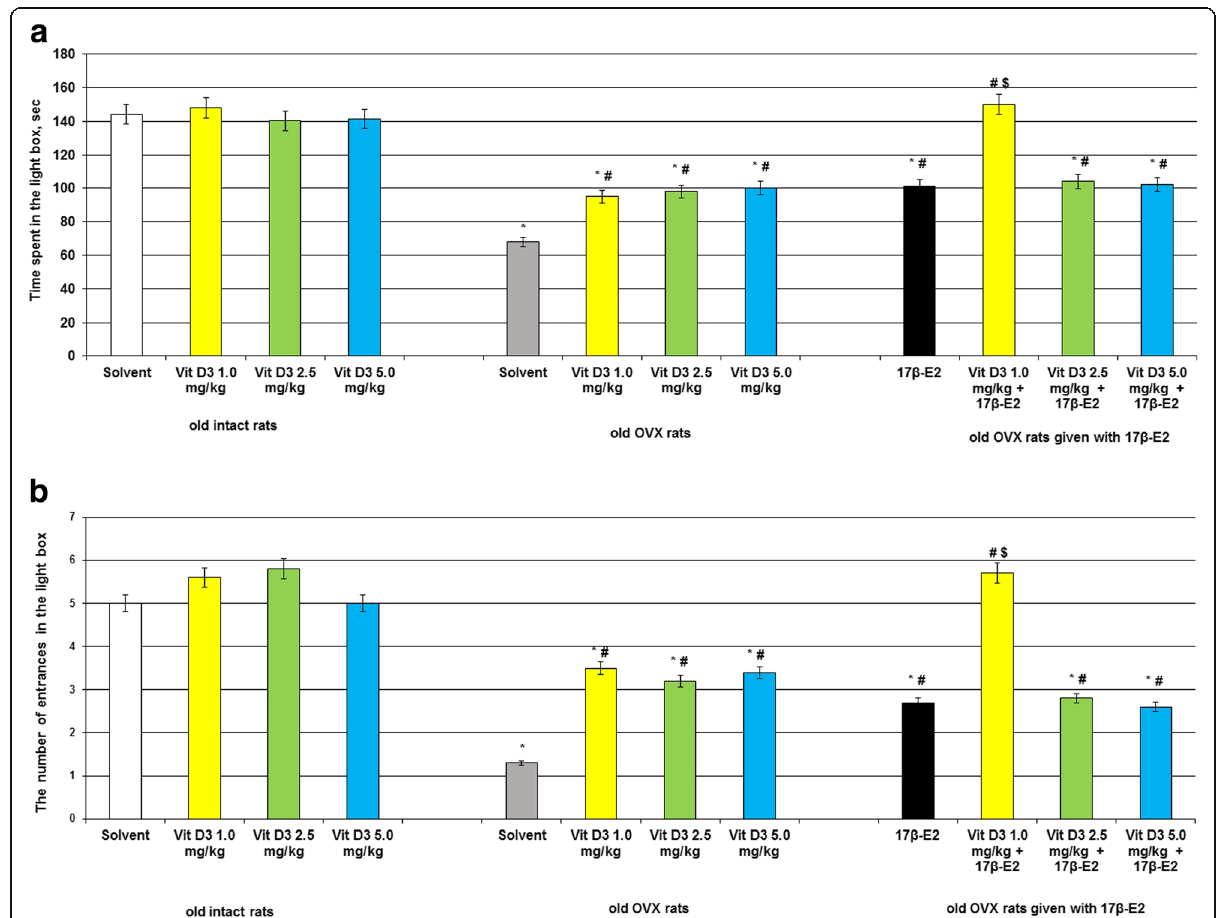
Fig. 2 Effects of Vitamin D 3 administration on anxiety-like behavior of the old OVX rats following long-term estrogen deficiency in the light/dark test. a – time spent in the light box, sec; b – the number of entrances in the light box. The obtained results show the mean ± standard error of the mean (SEM). * – p < 0.05 as compared to the control group of sham-operated rats, # – p < 0.05 as compared to the old OVX rats treated with solvent, $ – p <0.05 as compared to the old OVX rats treated with 17 β -estradiol. Each group comprised a minimum of eight rats. Cholecalciferol was given at 1.0, 2.5 or 5.0mg/kg/days.c., once daily, for 14days. The administered dose of 17 β -estradiol (17 β -E 2 ) was 0.5 μ g/rat s.c., once daily, for